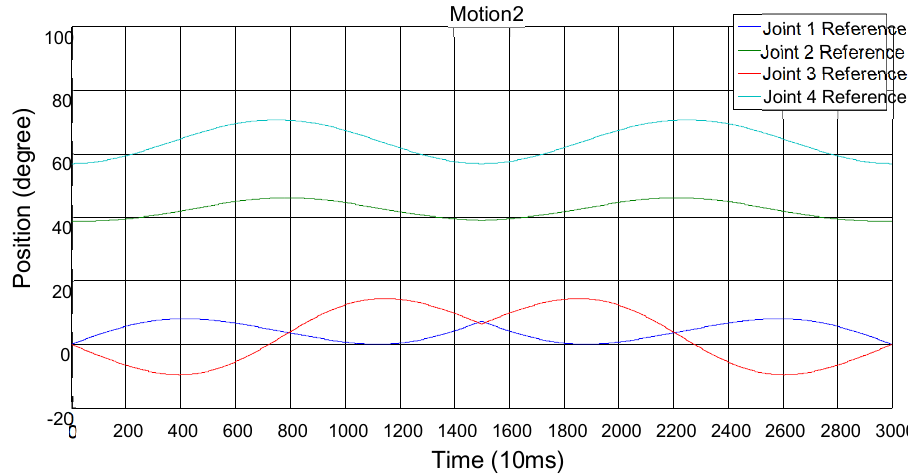
21 of 29 Figure 18. Motion trajectory 1 of each axis of the robot arm is planned by kinematics. Table 7. Rehabilitation trajectory 1—curvilinear equation in space. Rehabilitation Trajectory 1